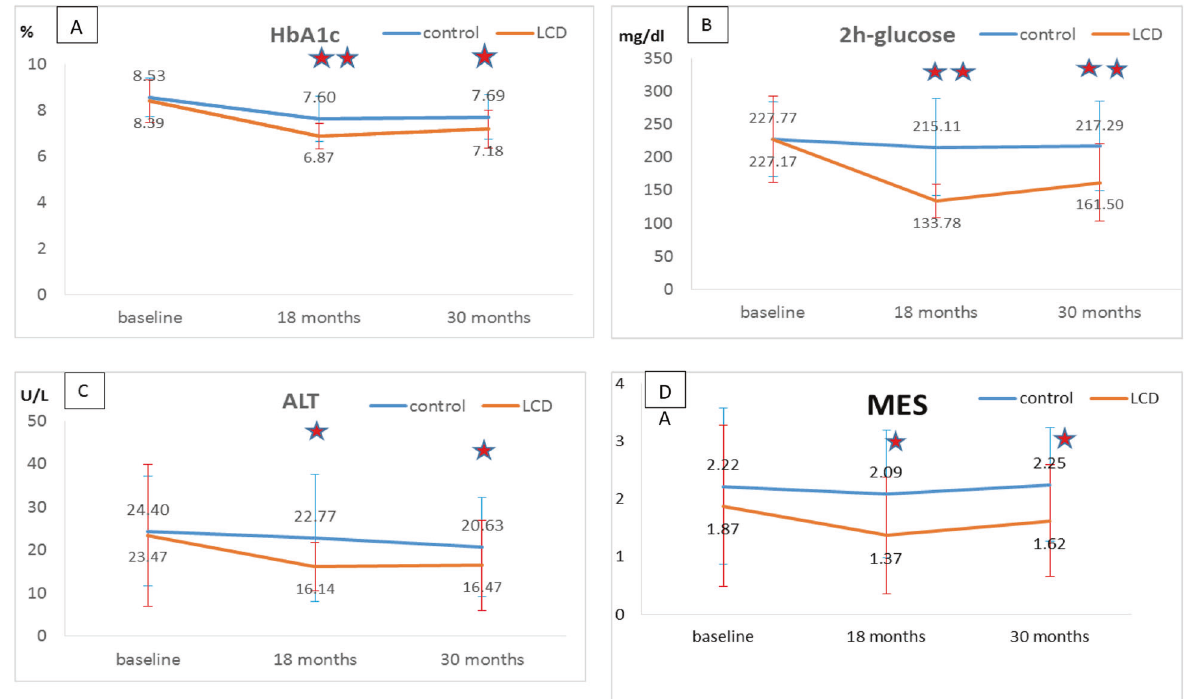
Fig. 1 Baseline, 18-month and one-year (30-month) follow-up across dietary intervention groups. HbA1c ( A ), 2 h glucose ( B ), ALT ( C ), and MES ( D ) were signi fi cantly different between the TDD and LCD groups (* p < 0.05; ** p < 0.001). MES medication effect score, ALT alanine aminotransferase, TDD traditional diabetic diet, LCD low carbohydrate